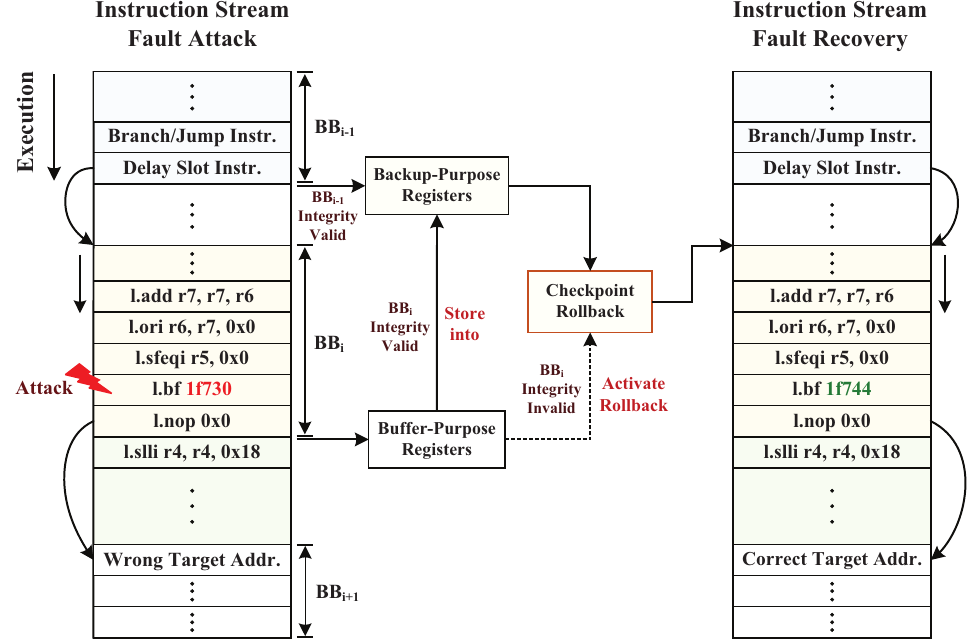
Figure 5. Example of instruction tampering attack and fault recovery aim at the benchmark of